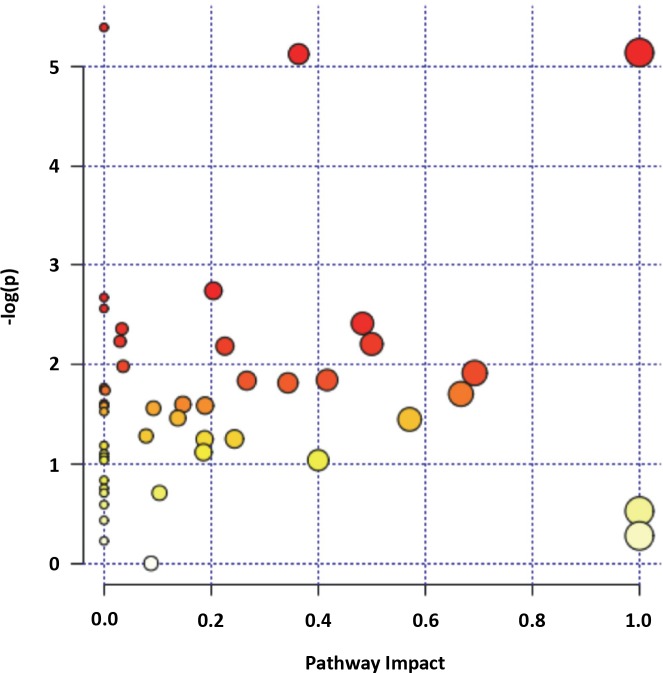
Pathway analysis of midgut metabolites identified in JNK SMI-treated A. stephensi.For comparison among different pathways, node importance values calculated from centrality measures were further normalized by the sum of the importance of the pathway. Therefore, the total/maximum importance of each pathway is 1. The importance measure of each metabolite node is the percentage of the total pathway importance, and the pathway impact value is the cumulative percentage from the matched metabolite nodes.